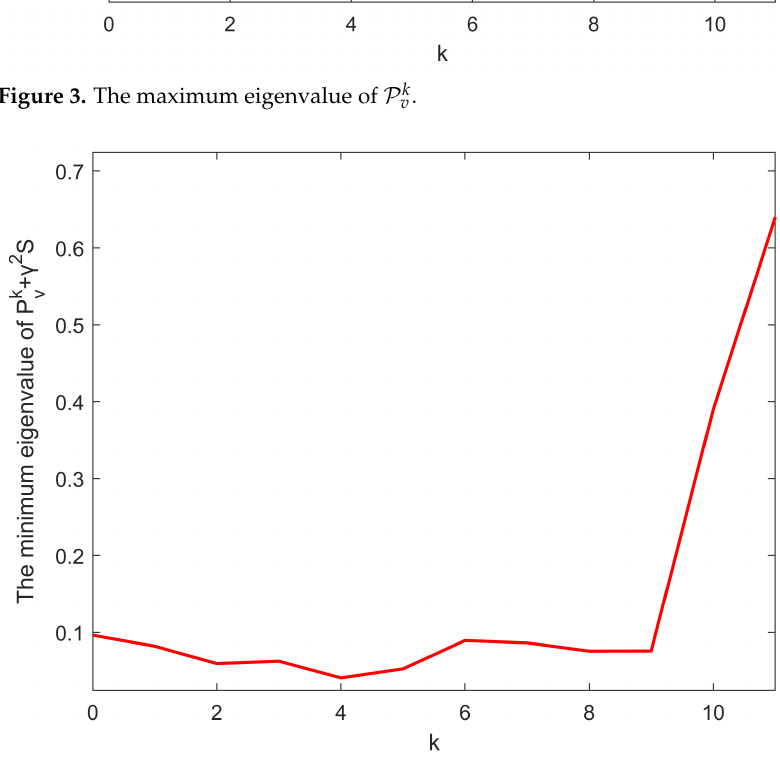
Figure 4. The minimum eigenvalue of P k v + γ 2 S